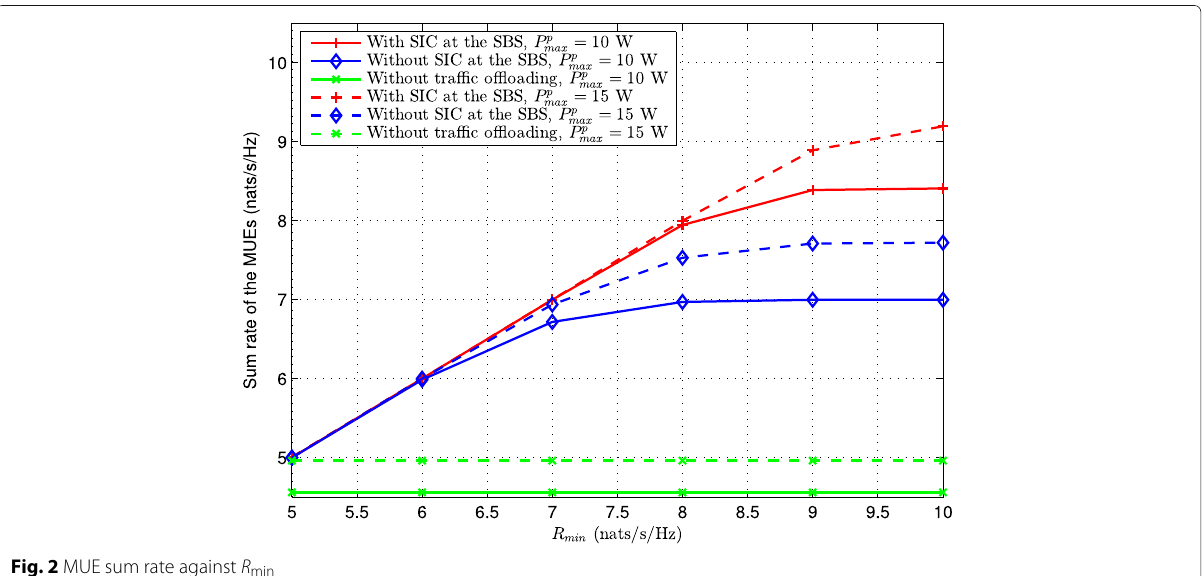
Fig. 2 MUE sum rate against R min